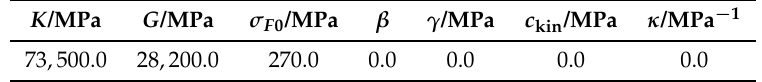
Table 3. Material parameters for aluminum with ideal-plastic behavior, used in the reference